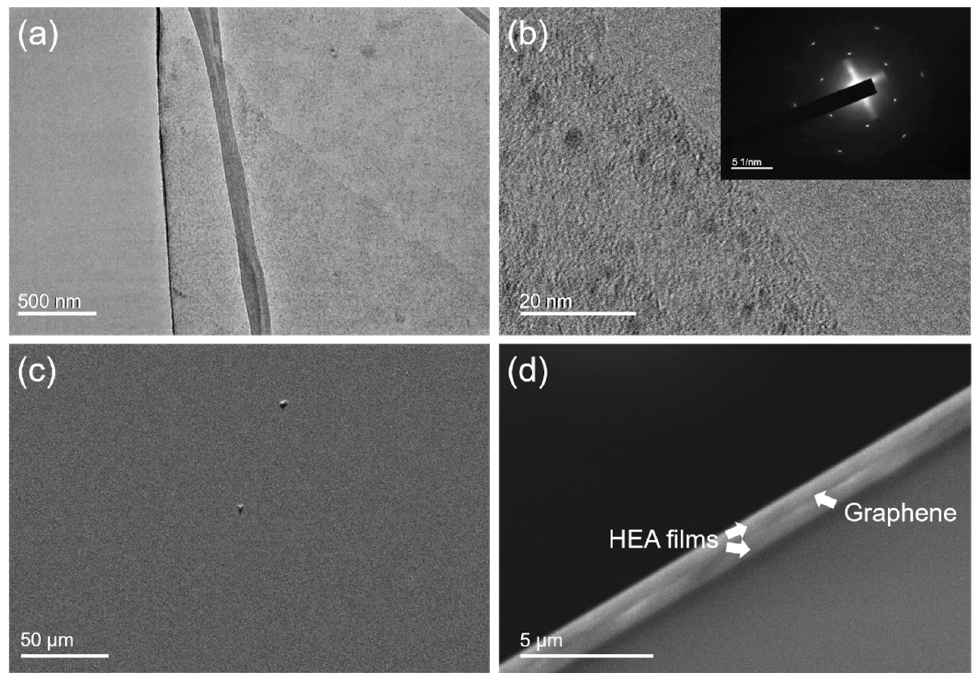
Figure 3. Characterization of the monolayer graphene and its assembling. TEM observation of ( a ) the freestanding graphene before transfer and ( b ) the edge of the suspended graphene; SEM observation of ( c ) graphene on the HEA surface and ( d ) cross-sectional NL HEA/graphene composite.